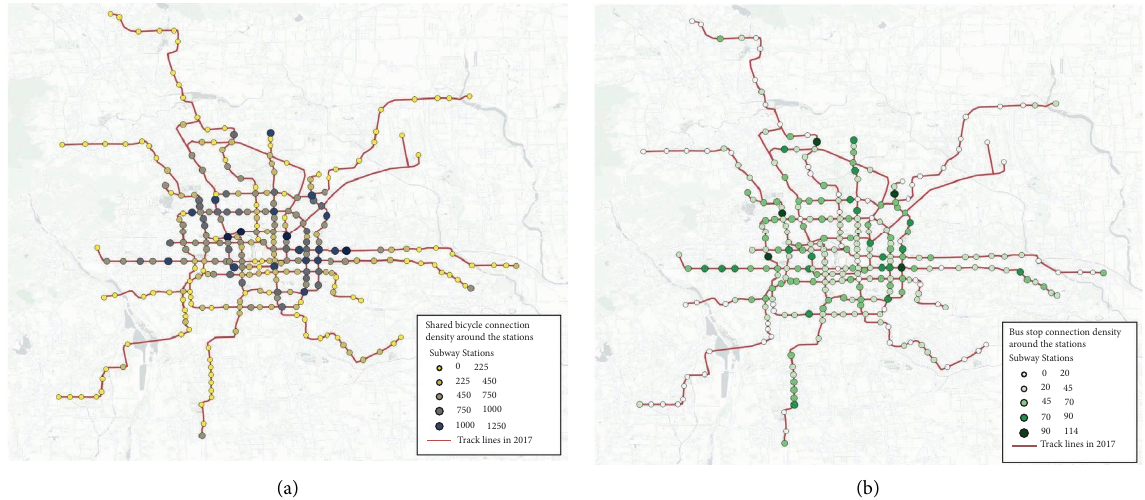
Figure 14: Other transportation connections. (a) Shared bicycle connection density around the stations; (b) bus stop connection density around the stations.